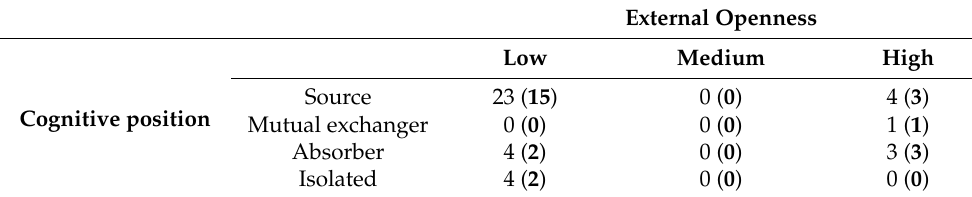
Table 5. Cognitive roles: market knowledge exchange 1 .